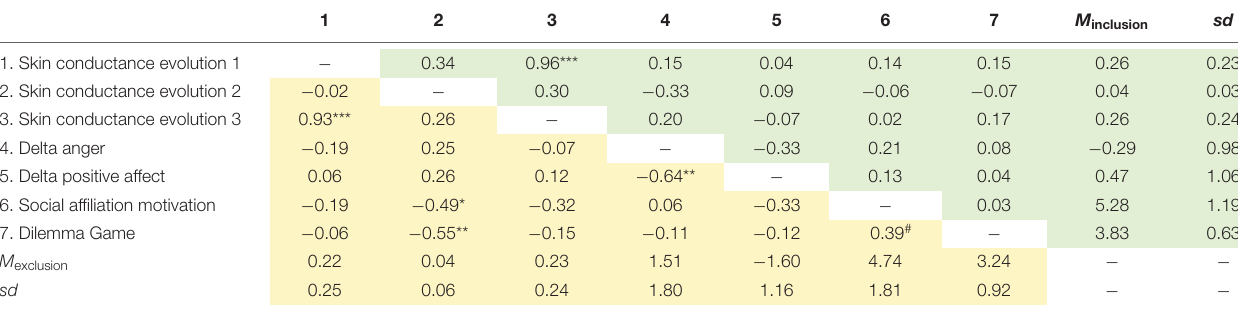
TABLE 2 | Correlation and means of the study variables.